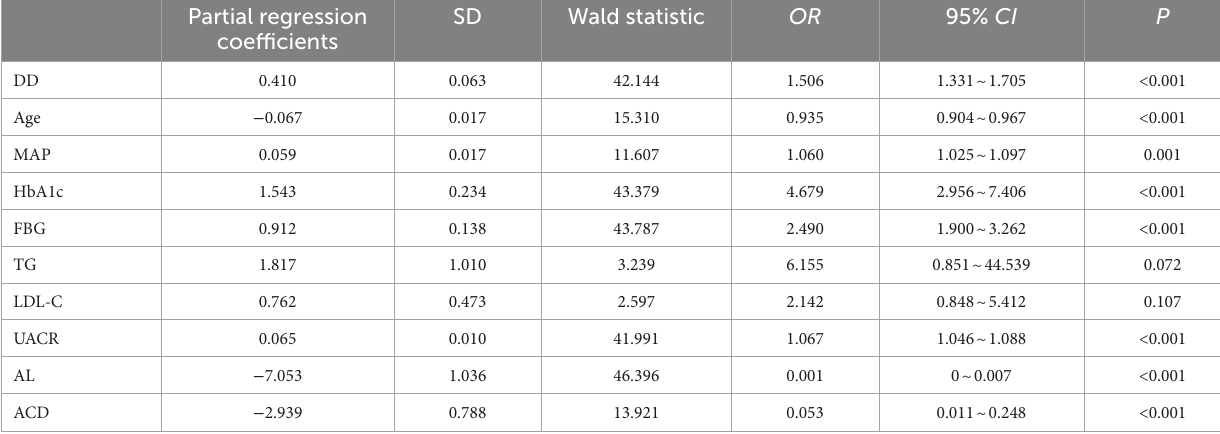
TABLE 3 Univariate logistic regression analysis of risk factors for DR. Partial regression coefficients